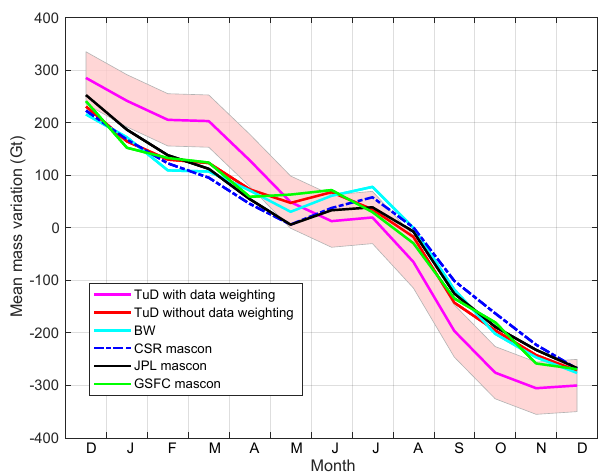
Figure A4. The mean mass anomalies per calendar month of the total–SMB residuals over the entirety of Greenland estimated from different GRACE solutions. “BW” refers to the solution of Wouters et al. (2008).